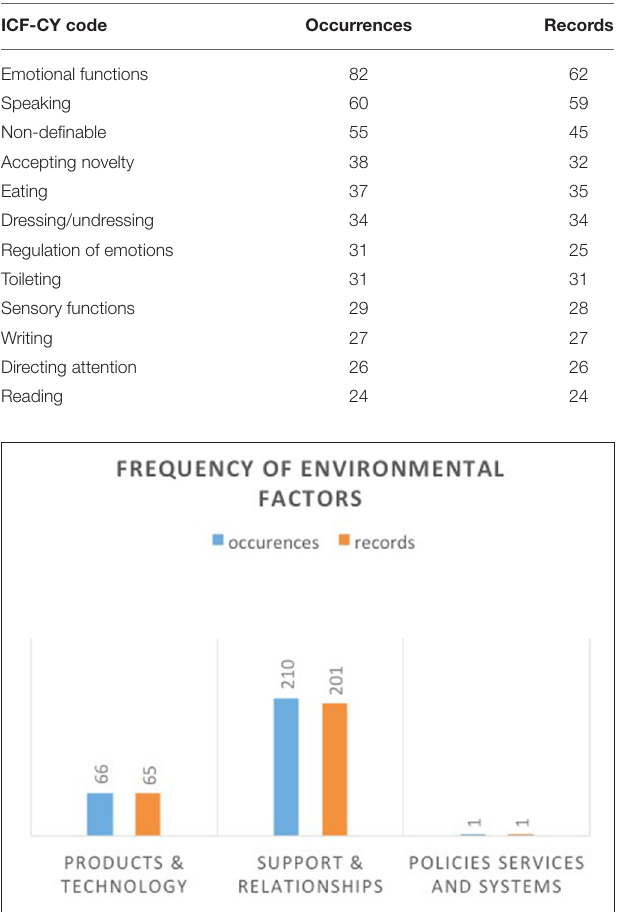
FIGURE 3 | Frequency of environmental factors in section A of the plans, matched with the ICF-CY classification